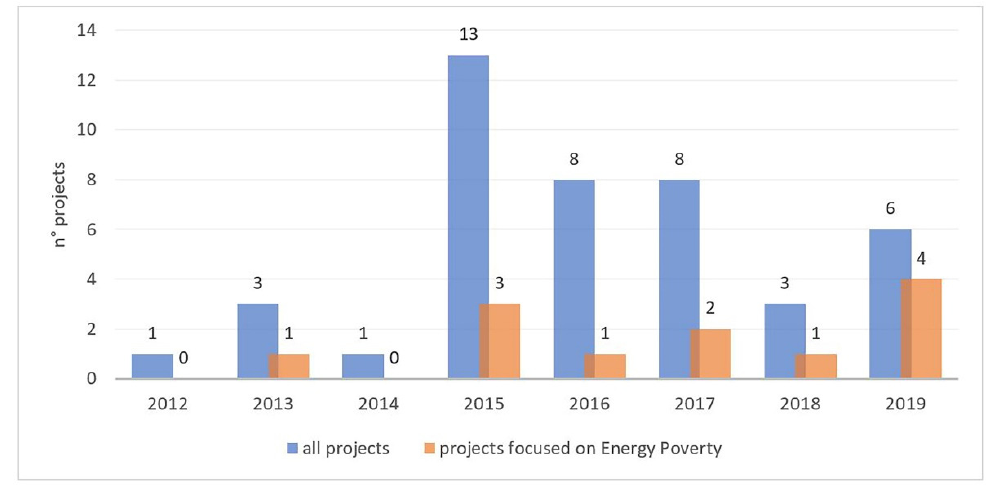
Figure 2. Number of projects per year. Image elaborated by the authors.